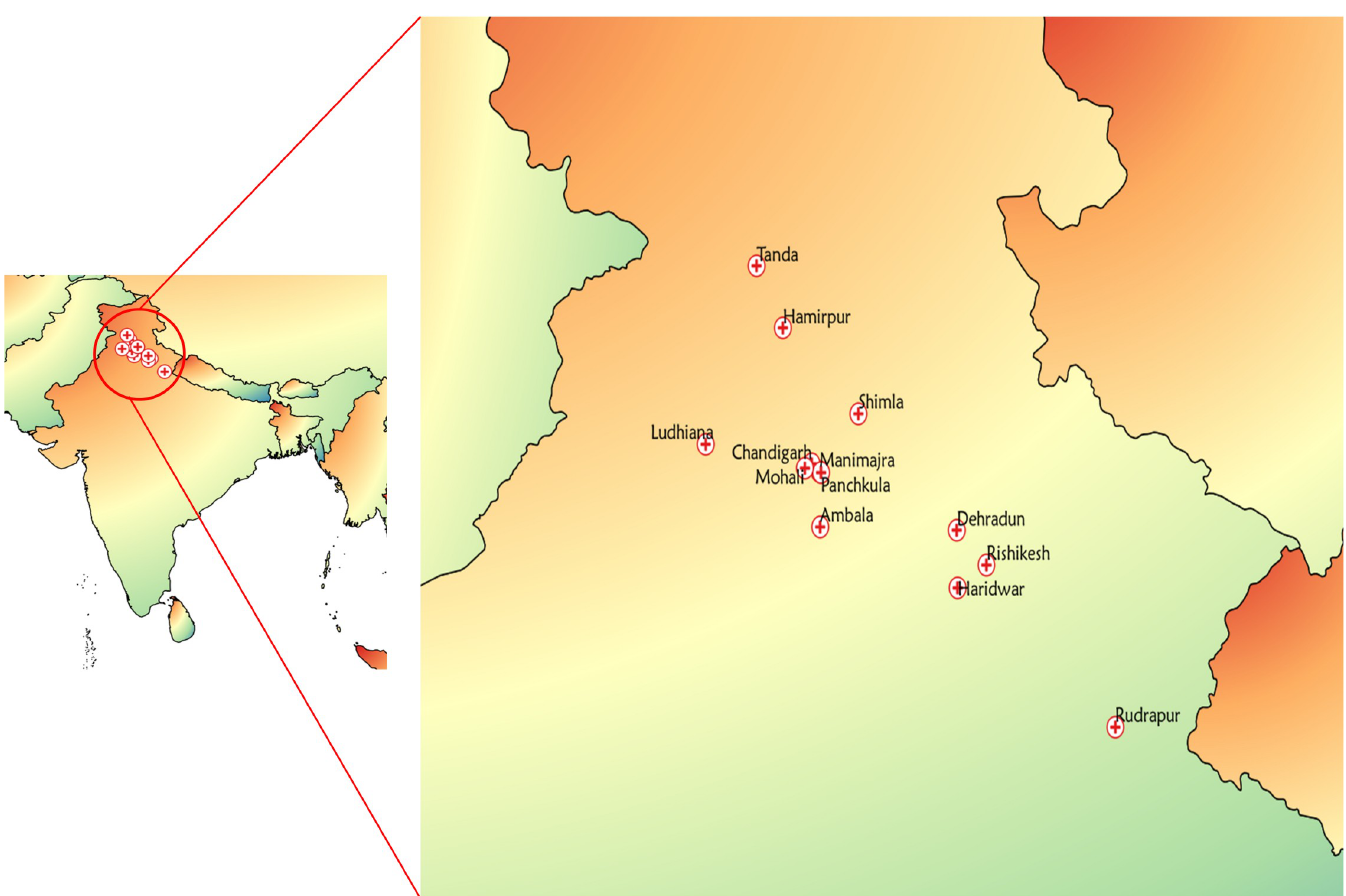
Fig 1. Representation of sampling sites of the regional health centers of different cities across the North India region [Chandigarh (PGIMER), Civil hospital Manimajra; Haryana (Civil hospital Panchkula and Civil hospital Ambala Cantt); Himachal Pradesh (Government Medical College (GMC) Hamirpur,